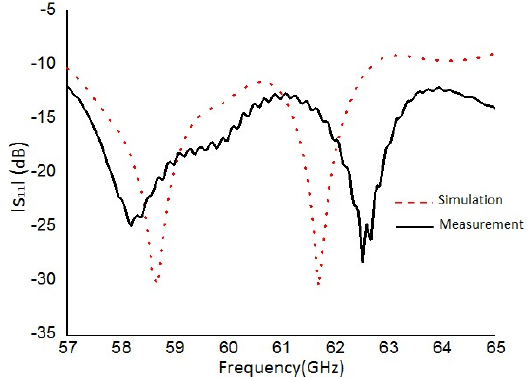
Figure 15. Measured and simulated S-parameters curves versus frequency of the proposed mmWave 5G antenna array. 5G antenna array.